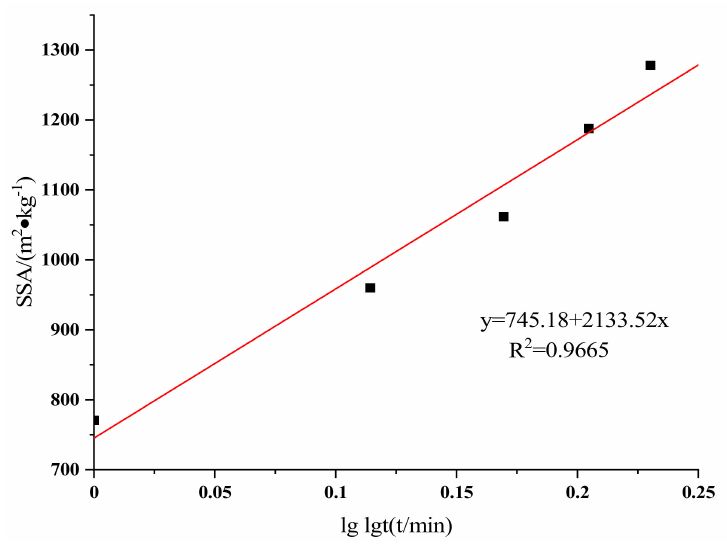
Figure 7. Relationship between the SSA of LVTC powder and the double logarithm of grinding